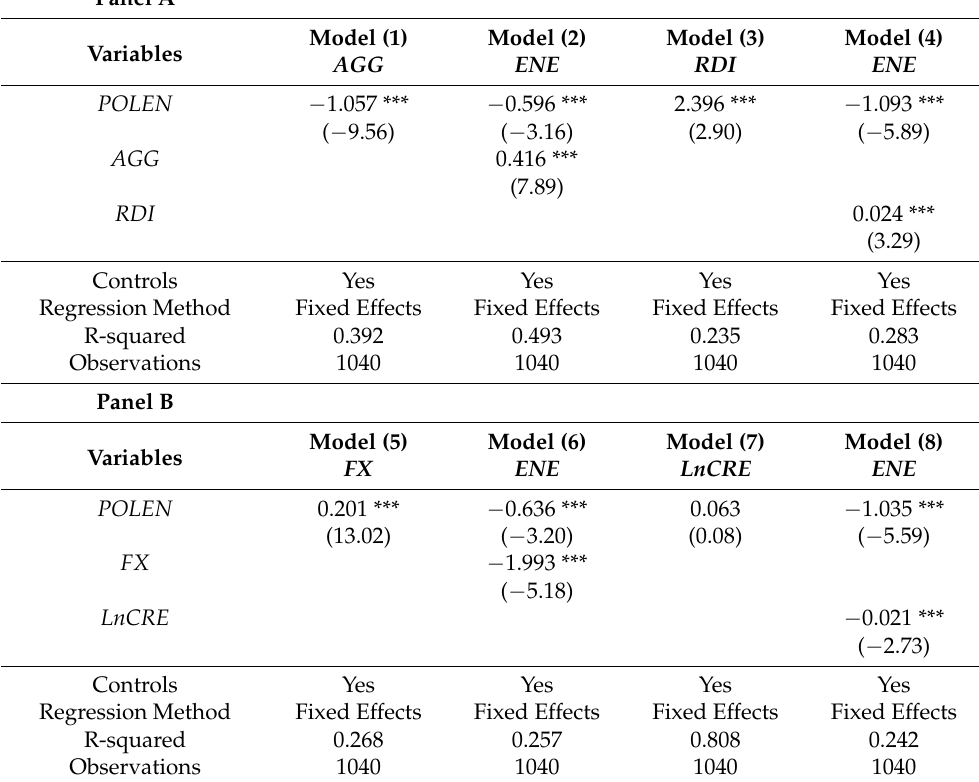
Table 4. Mediating Effect Test